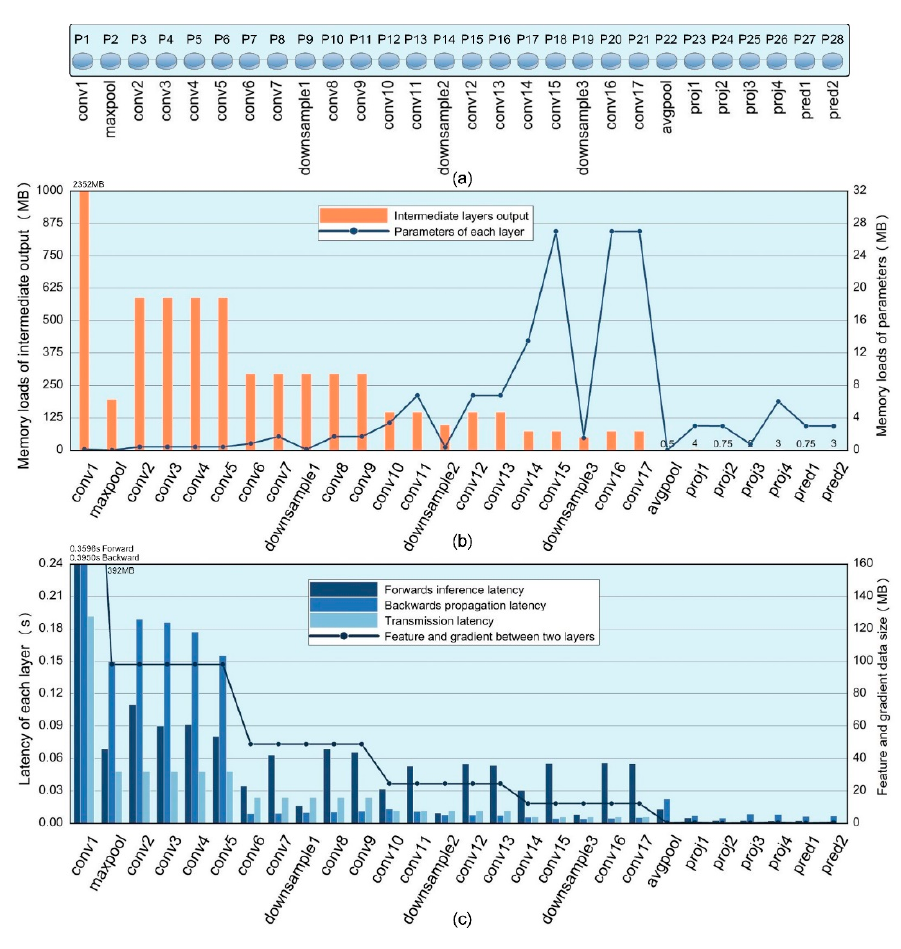
Figure 13. Data collected by CWB. ( a ) Partitionable layers contained in the Lite-SRL network structure, corresponding to 28 partitionable points { p 1 , p 2 , · · · p 28 } . ( b ) CWB calculated the memory workload occupied by each network layer during the training process, including the intermediate variables and network parameters for each layer. ( c ) CWB measured time consumption, including inference latency and backward propagation latency of each layer when trained on TX2, together with the data transmission latency between TX2. The transmission latency was derived from the gradient data size between two layers and the inter-device transfer rate.